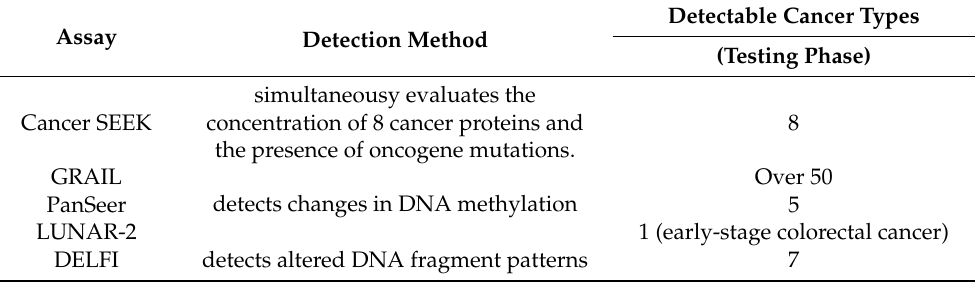
Table 1. Summary of ctDNA tests for cancer